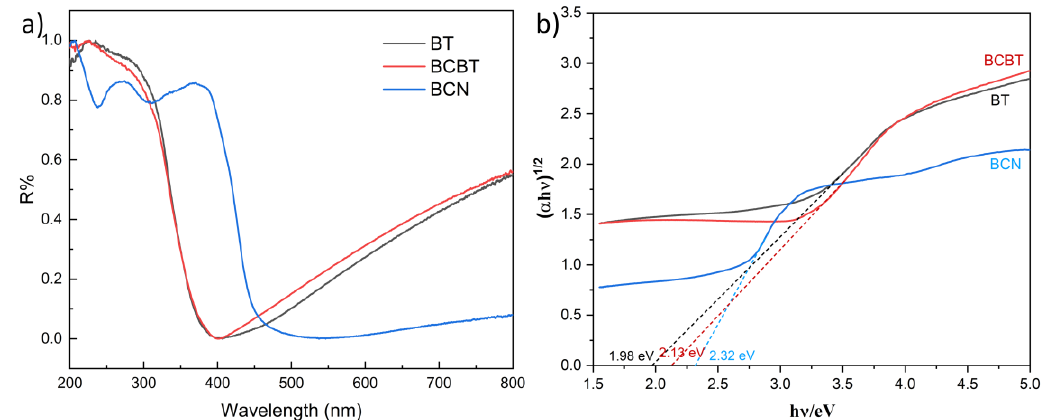
Figure 4. ( a ) UV-vis diffuse reflectance spectra of the as-prepared BT, BCN, and BCBT. ( b ) Relationship of (ah ν ) 1/2 vs. E